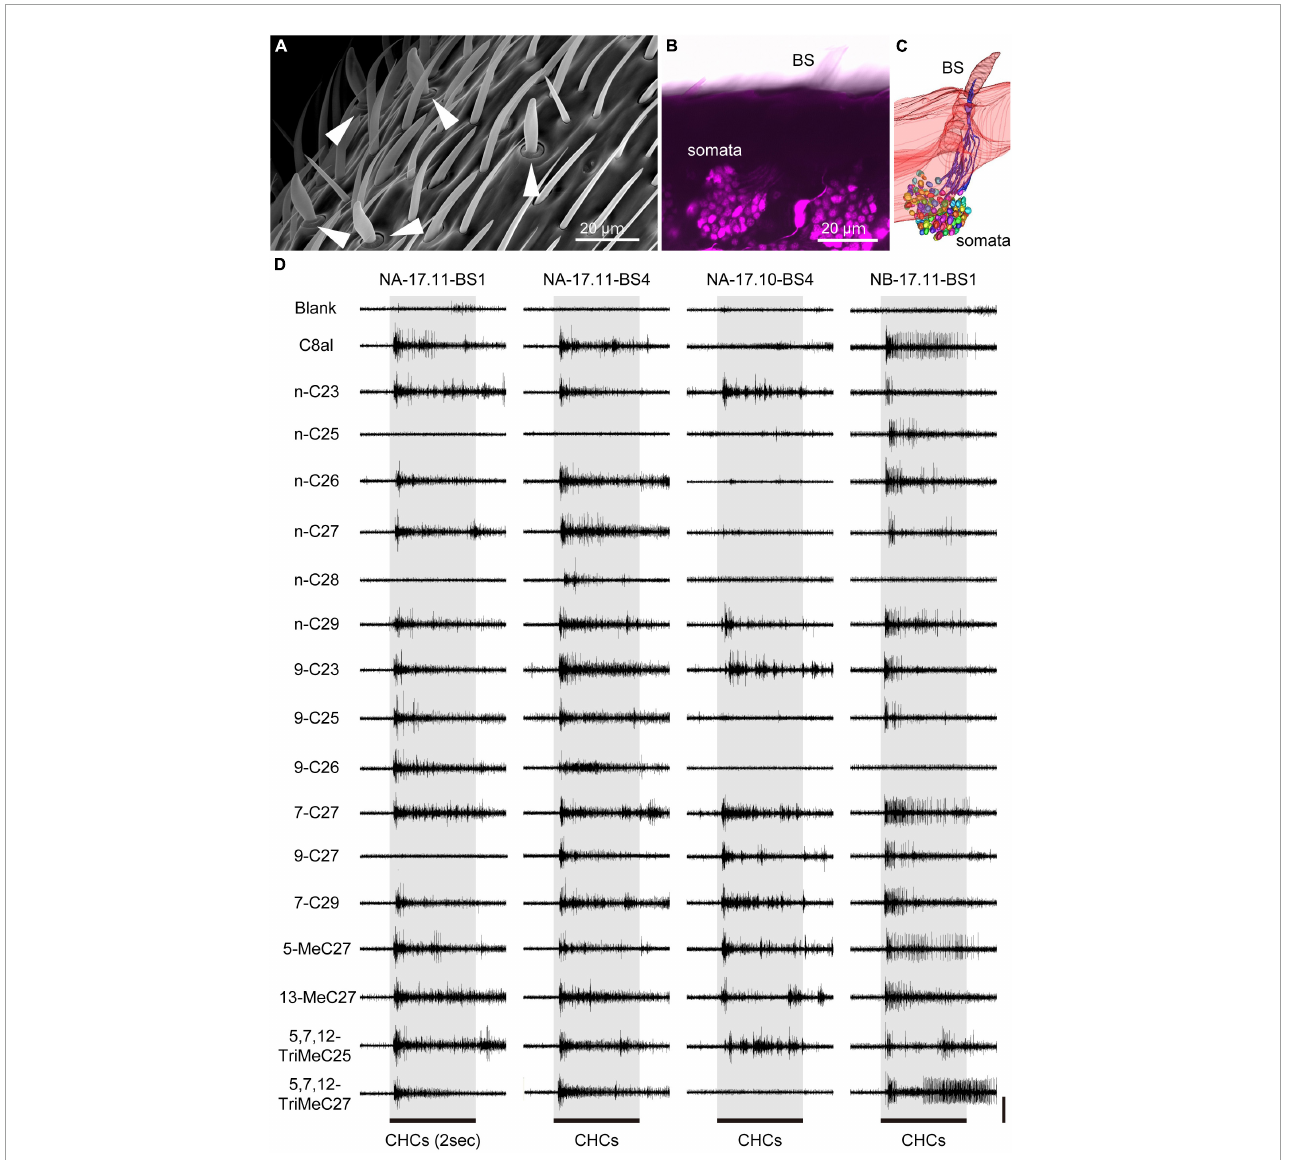
FIGURE1 Extracellular recordings from single basiconic sensilla in C. japonicus . (A) Basiconic sensilla on the ant antenna. Basiconic sensilla are indicated by arrowheads. (B,C) SNs in a basiconic sensillum. Retrograde staining of antennal afferents (B) and their 3D reconstruction (C) revealed approximately 140 SNs in a single basiconic sensilla. (D) Responses of four basiconic sensilla to tested CHCs. Each basiconic sensillum exhibited “all-or-nothing” responses to tested CHCs. Recorded basiconic sensilla are termed by “colony name (NA, NB, or NC)–sampling date (year. month)–sensillum number (BS1-6)”. The 2-s CHC stimuli are indicated by gray boxes and horizontal bars under the electrophysiological traces. CHC responses of 23 sensilla used in this study are denoted in Supplementary Figures 3 – 5 . Vertical bar = 0.2